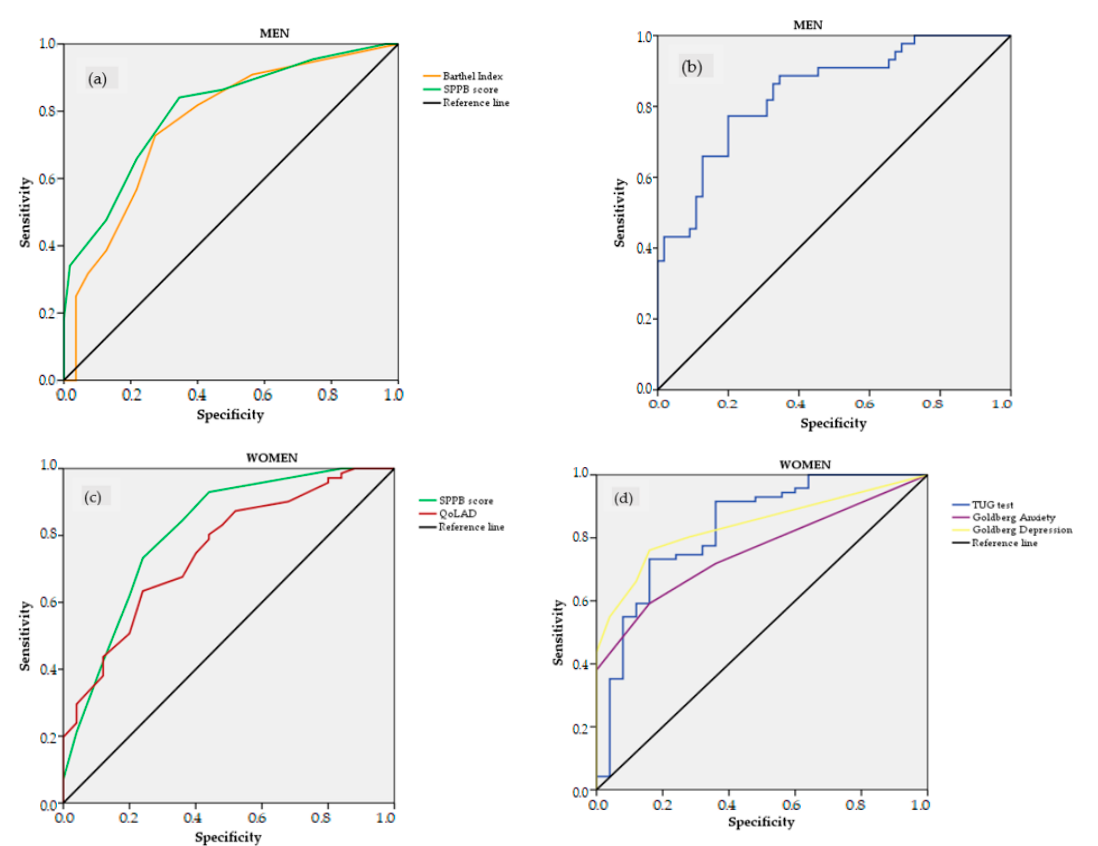
Figure 2. Receiver operating characteristic (ROC) curves to identify frailty by Fried Frailty Phenotype (FFP) in men ( a , b ) and women ( c , d ) using different measures: Barthel Index, Timed Up and Go (TUG) test, Short Physical Performance Battery (SPPB) score, Quality of Life in Alzheimer’s Disease (QoLAD), and Goldberg Anxiety and Depression scales. ROC curves of TUG test (for men and women) and Goldberg Anxiety and Depression scales (for women) have been plotted inverted for better comparison.